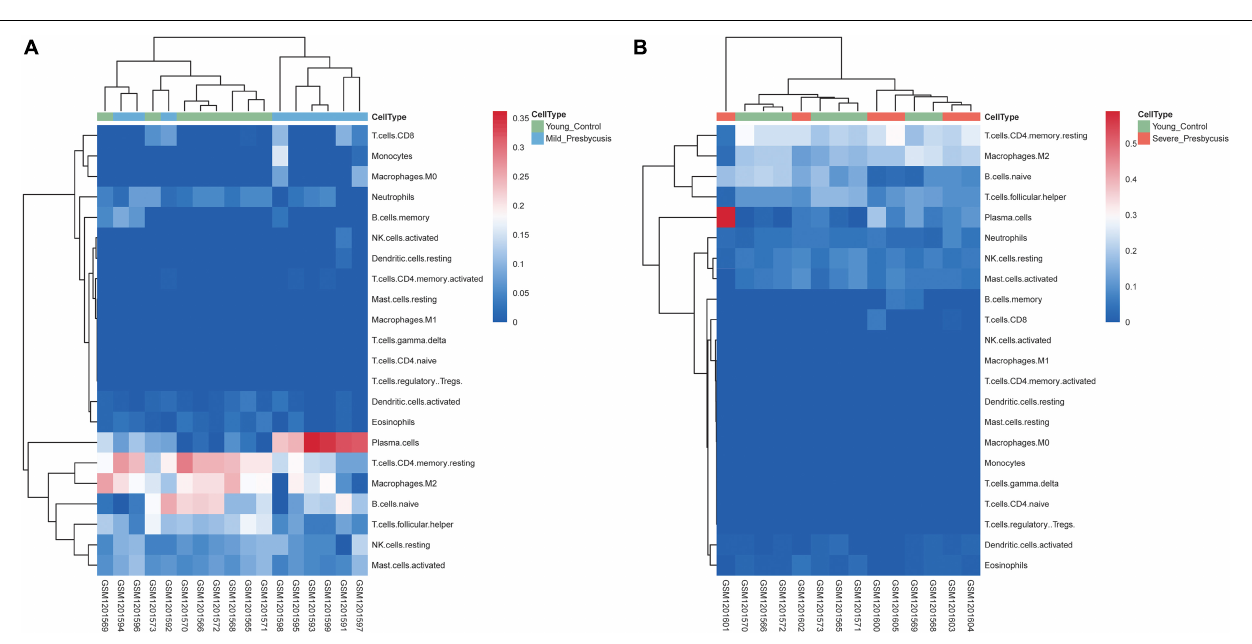
Frontiers in Medicine |